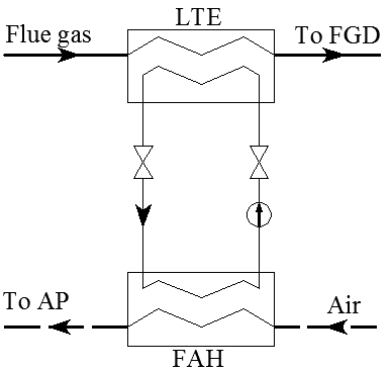
Figure 3. Traditional LTE–FAH system. AP: Air Preheater; FAH: Front located Air Heater; LTE: Low Temperature Economizer; FGD: Flue Gas Desulfurization.